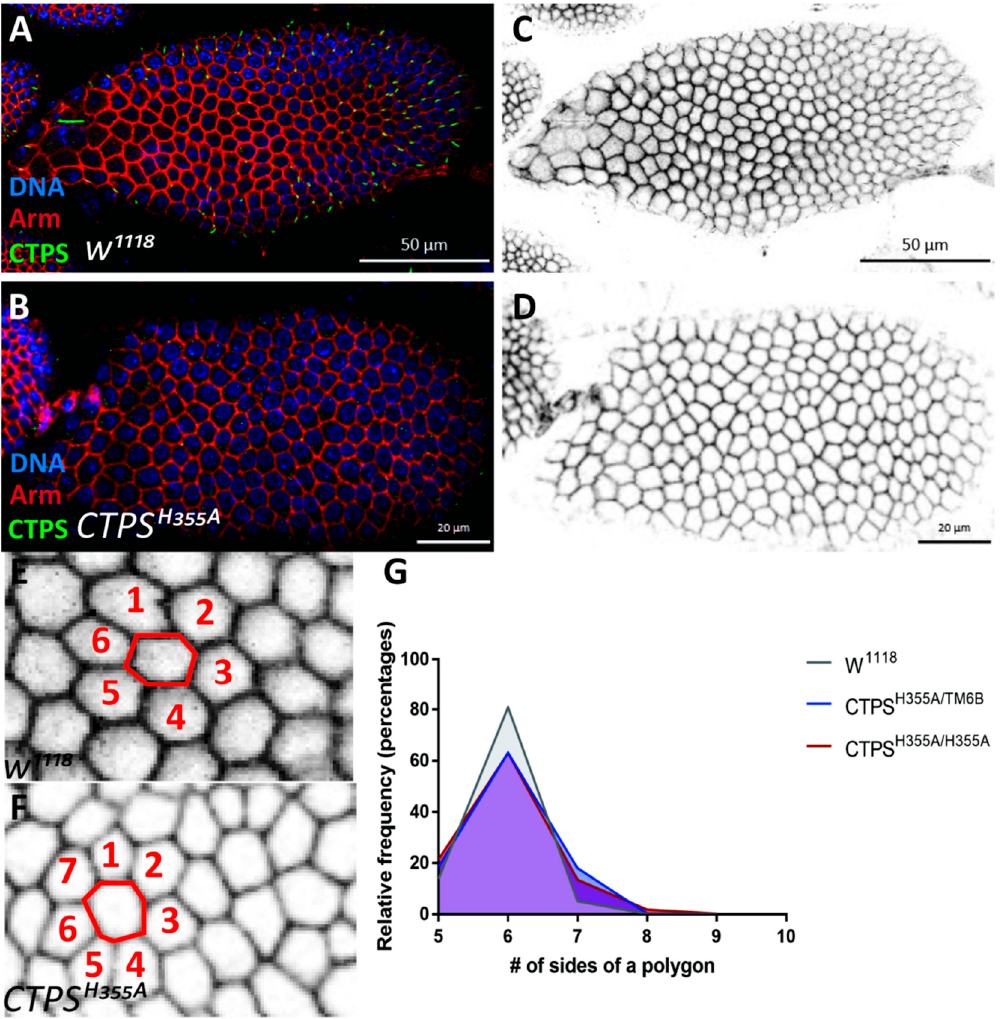
Figure 7. Morphological comparision of follicles between wild-type and CTPS H355A . ( A – F ) Surface view of stage 8 egg chambers. Membrane was labeled by Armadillo (red), and CTPS is shown in green. ( A , C ) w 1118 egg chamber. Scale bars, 50 μ m. ( B , D ) CTPS H355A egg chamber. Scale bars, 20 μ m. ( E ) Zoom-in view of ( C ). ( F ) Zoom-in view of ( D ). Redlines in E and F outline a central follicle cell with neighboring follicle cells in numbers. Note that the number of neighboring cells reflects the number of sides of the central polygonal follicle cells. ( G ) Quantitative analysis of the morphological difference between the wild-type control and CTPS H355A follicle cells (6 egg chambers were quantified per genotype, biological repeats = 3).